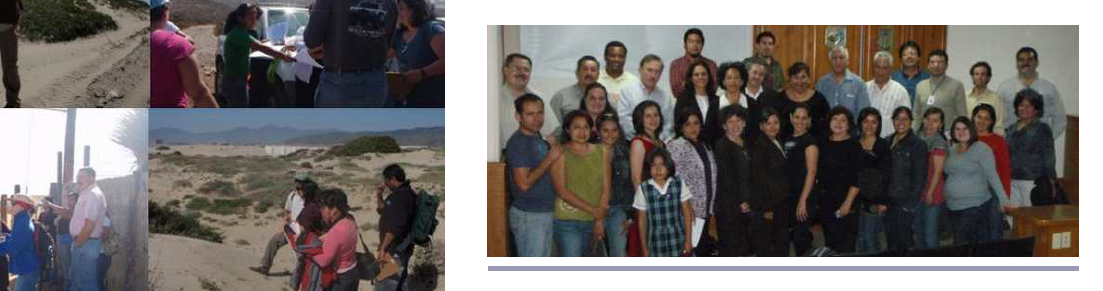
Fig. 7. Ecological and social research in the Campillo (taken from MEZA-UABC 2010).